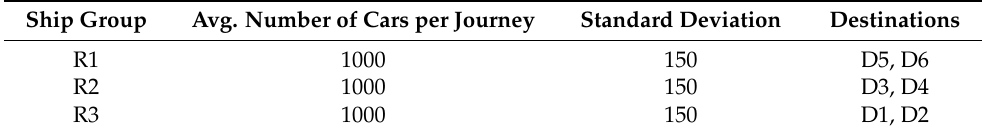
Table 2. Parameters of ships arriving in the generic